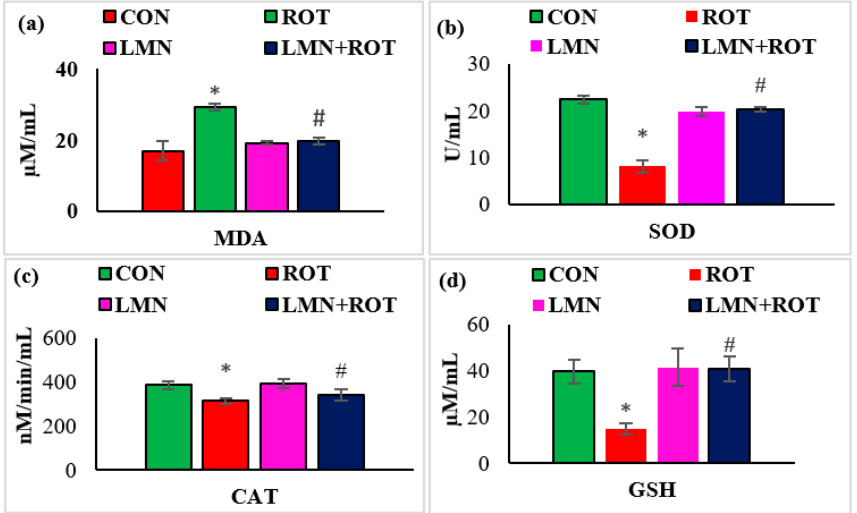
Figure 4. Effect of limonene on the levels of MDA, SOD, catalase (CAT), and GSH in the midbrain of rats ( a – d ). The values are presented as mean ± SEM (n = 6–8); * p < 0.05 CON vs. ROT; # p < 0.05